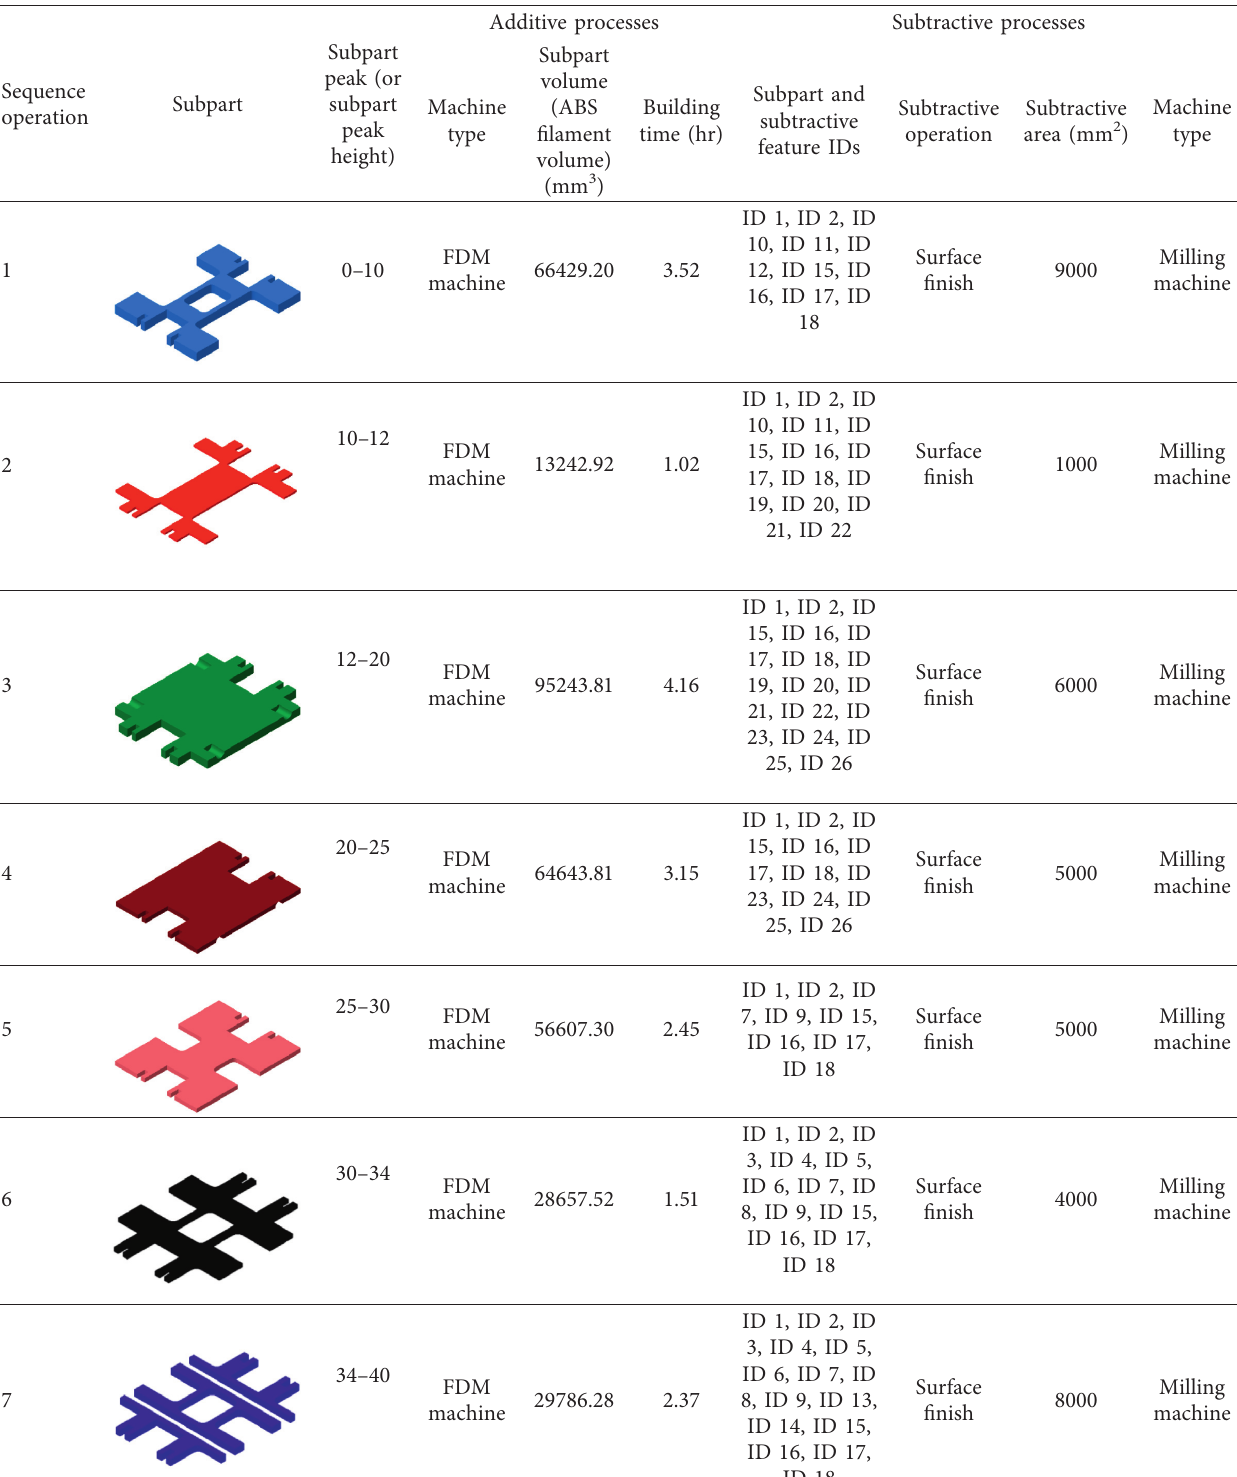
Table 13: All possible peaks and